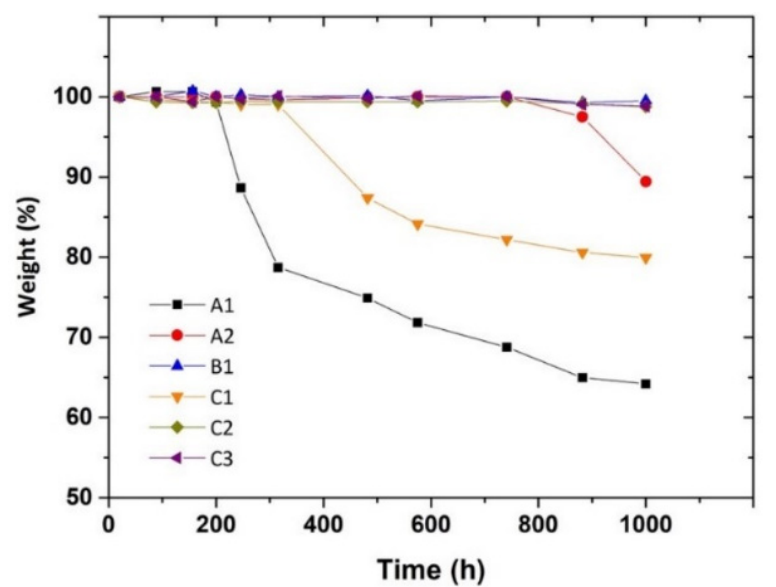
Figure 1. Weight changes of the layers exposed to isothermal aging at 110 ◦ C as a function of treatment